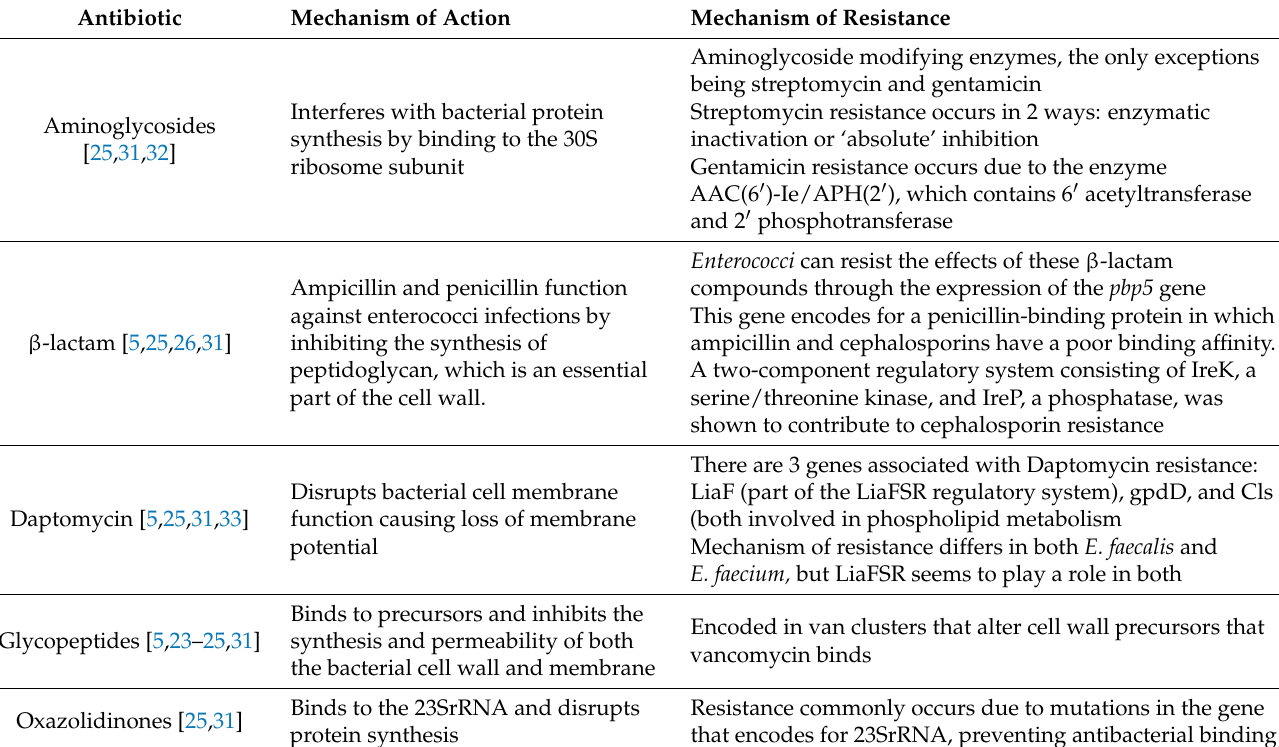
Table 2. Antibiotic mechanisms and enterococcal